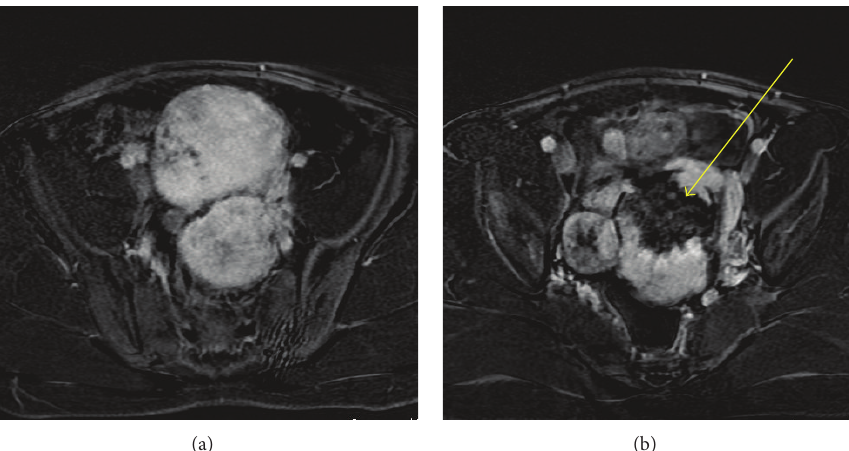
Figure 3: MRI imaging. (a), (b) Axial postgadolinium images demonstrate areas of significant enhancement within the pelvic masses with a central area of nonenhancement ( yellow arrow ) corresponding to the area of T1 hypointensity, which represents the fibrous portion of the tumor.